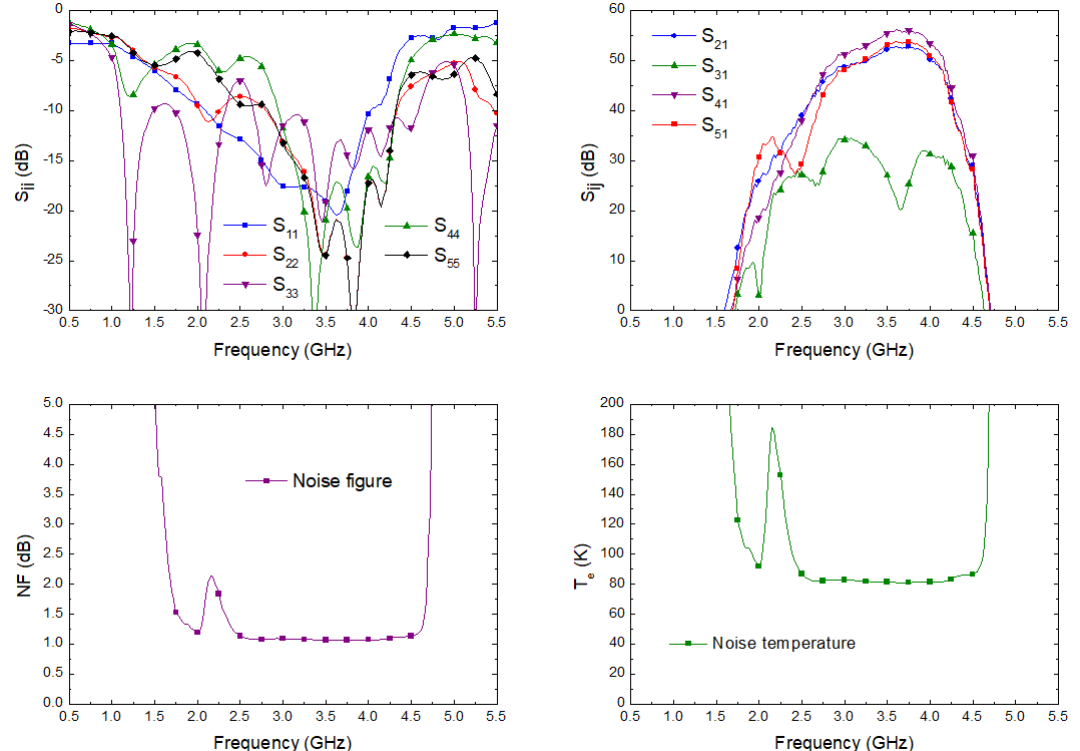
Figure 9. The simulated scattering parameters from the antenna input to each output port, noise figure, and equivalent noise temperature of the proposed